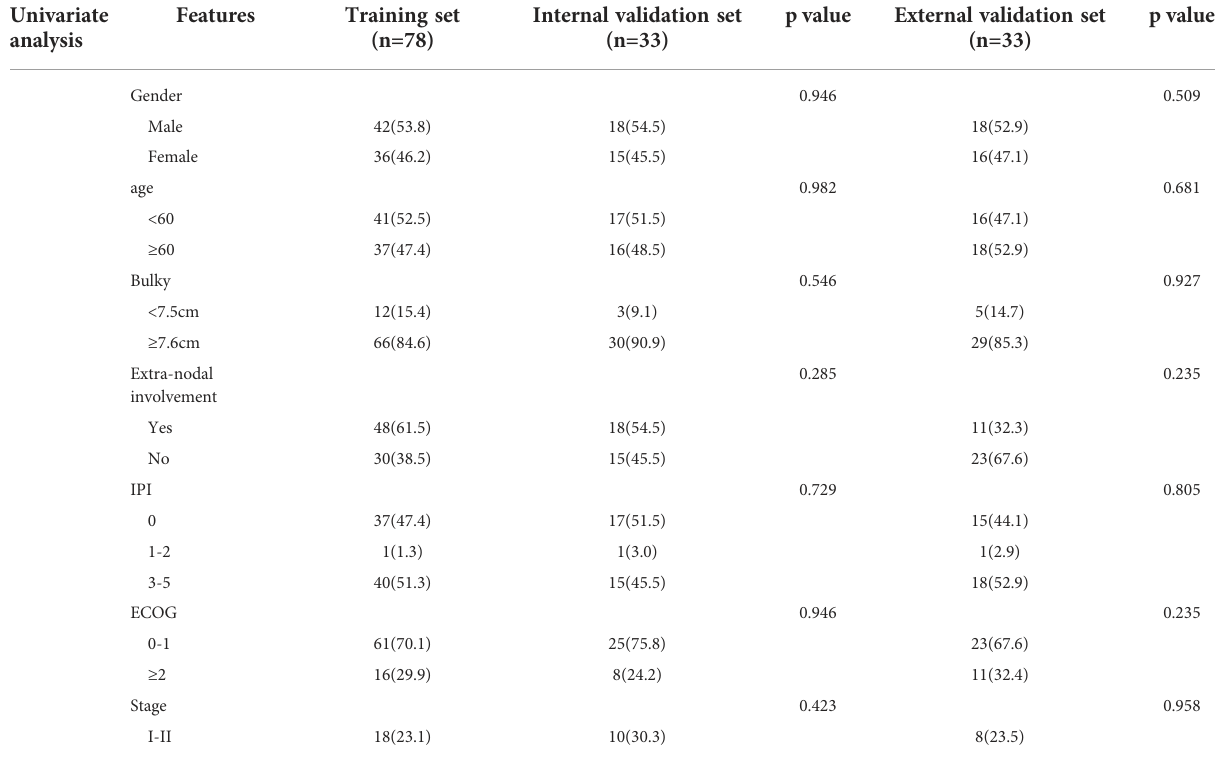
TABLE 1 Clinic and ultrasound features of training and validation